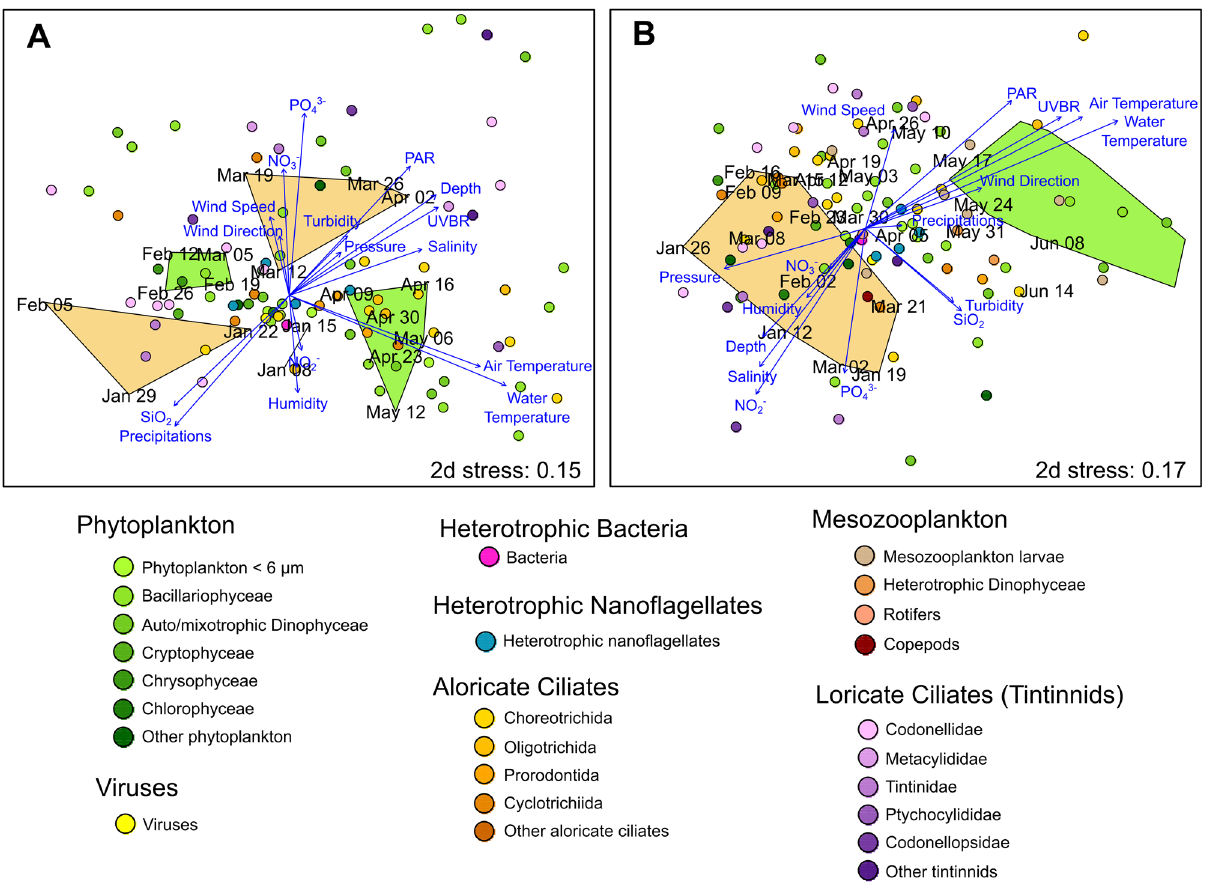
Figure 2. Non-metric multidimensional scaling (nMDS) of plankton community composition and environmental variables in 2015 ( A ) and 2016 ( B ). Plankton taxa are shown as circles, with colours reflecting the taxonomy depicted in the legend under the charts. Sampling dates are in black. Orange polygons delimit non-bloom periods, and green polygons delimit bloom periods. Blue arrows present the projections of environmental parameters. The proximity between environmental parameters or taxa and sampling dates indicates characteristic